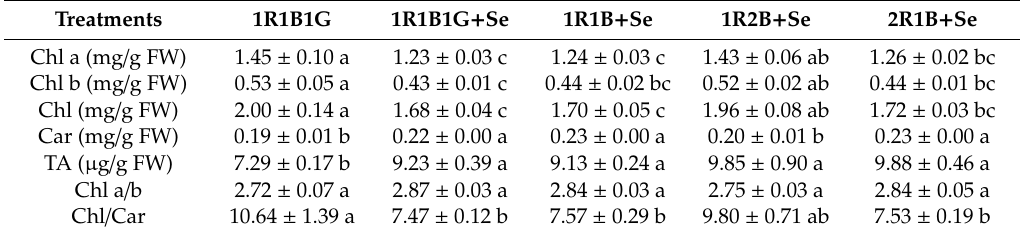
Table 2. Pigment contents of broccoli sprouts grown under a combination of selenium and LED light quality treatments.